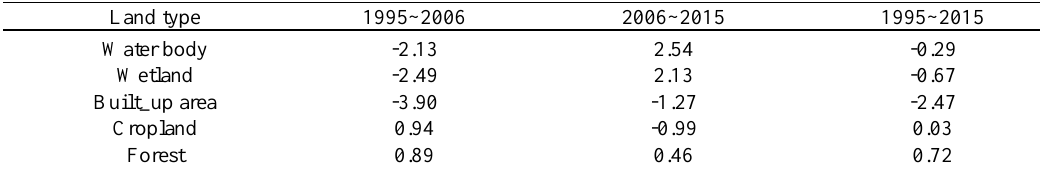
Table 3. Dongting Lake area change amplitude of single land